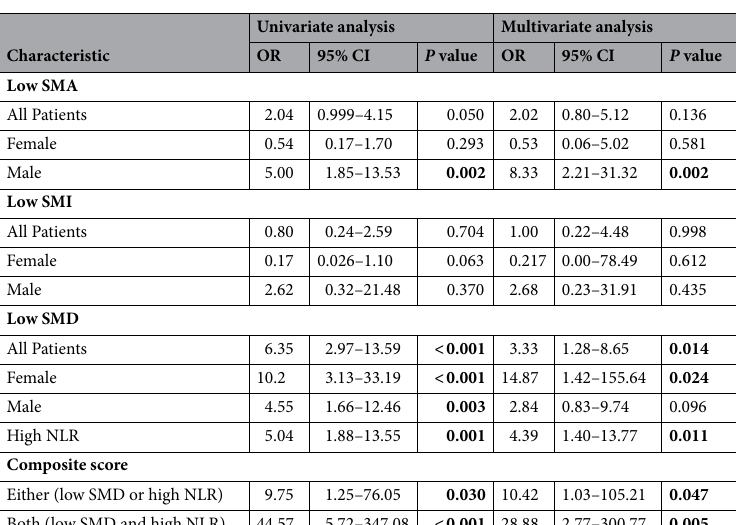
Figure 4. Overall survival according to: ( A ) skeletal muscle radiodensity; ( B ) neutrophil ‐ to ‐ lymphocyte ratio; and ( C ) skeletal muscle radiodensity and neutrophil ‐ to ‐ lymphocyte ratio composite score of patients with COVID-19. Abbreviations: SMD: Skeletal muscle radiodensity; NLR: Neutrophil-to-lymphocyte ratio.